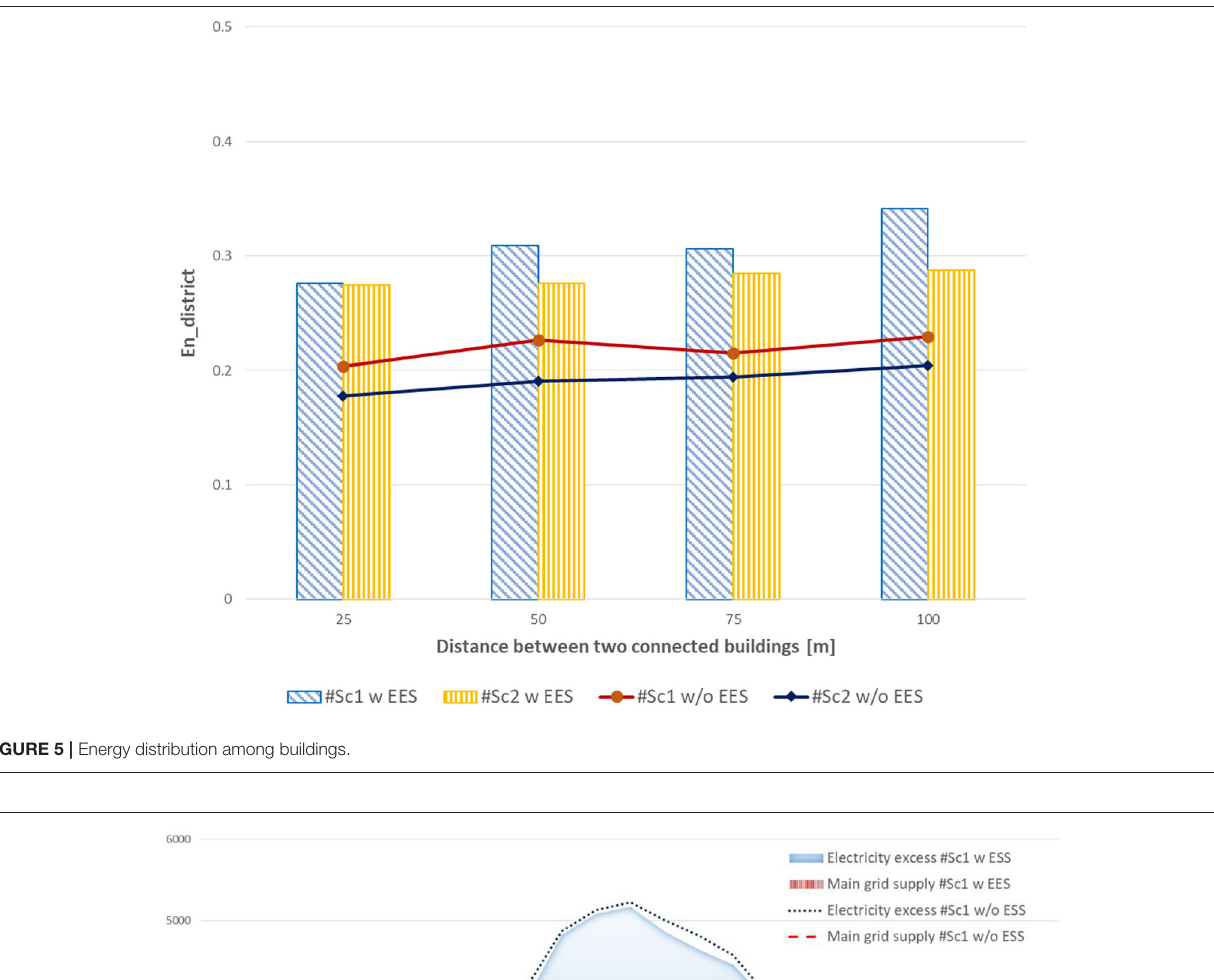
FIGURE 5 | Energy distribution among buildings.